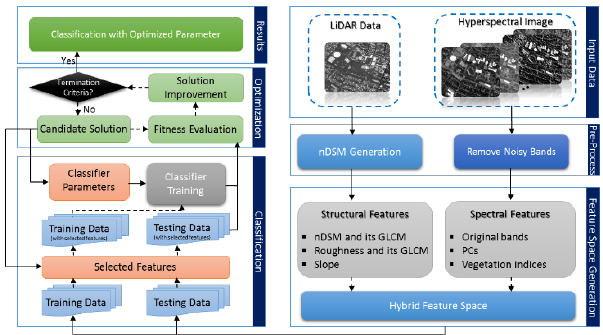
Figure 1. Flowchart of the proposed